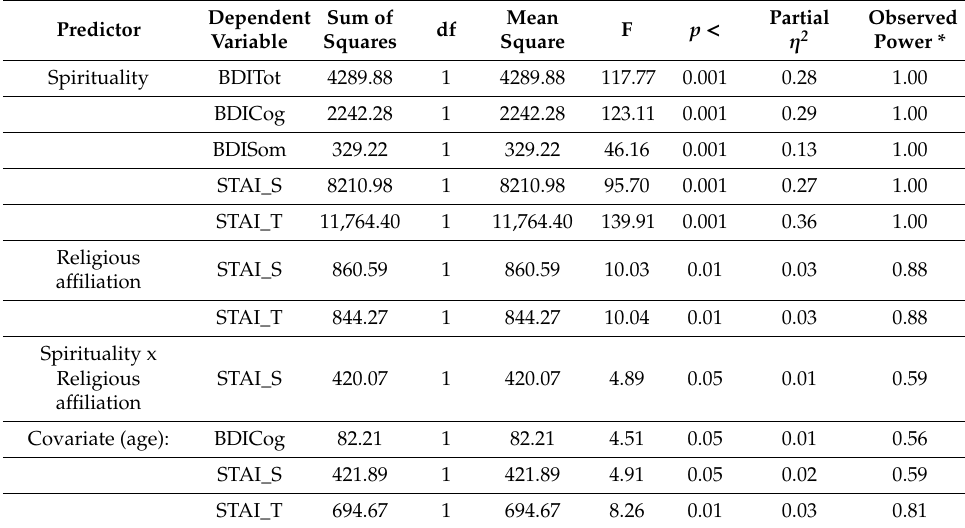
Table 3. The e ff ect of spirituality and religious a ffi liation on clinical